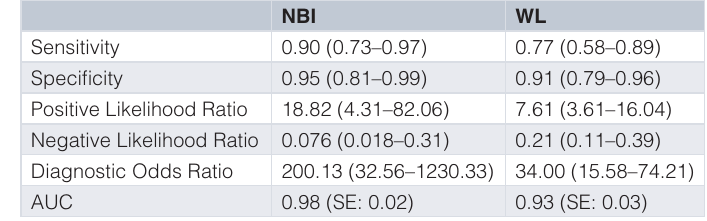
Table 3. Narrow-band imaging and white light endoscopy pooled data and